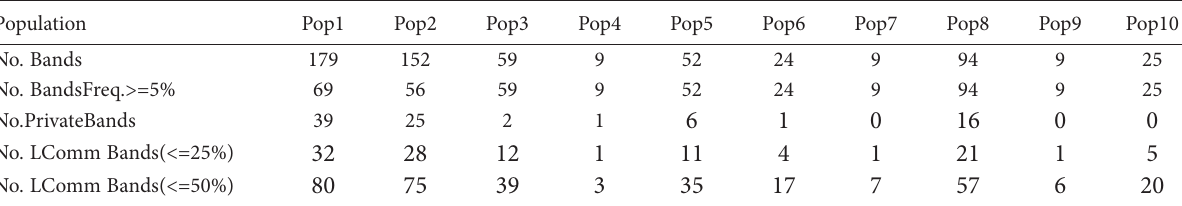
Table 1. Details of SSR bands in geographical populations of rice genotypes.